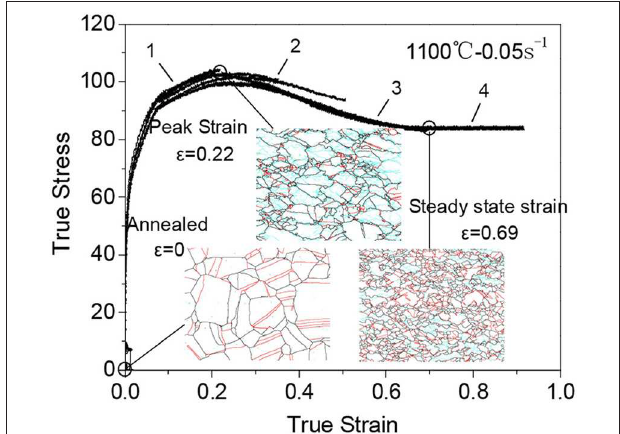
FIGURE 4 | Typical strains and grain boundary evolution during DRX of 316LN steel. 1, Stress-strain curve to the strain of 0.22; 2, strain of 0.51; 3, strain of 0.69; 4, strain of 0.69. Small angle boundaries are shown as light blue lines.